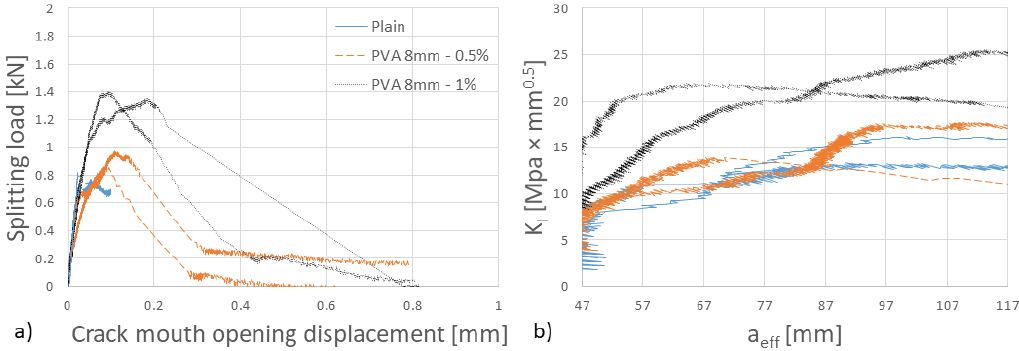
Figure 8. ( a ) Splitting load (SL) versus crack mouth opening displacement (CMOD) curves of concrete-FRC interfaces and ( b ) crack growth resistance curves in terms of stress intensity factor, K I , versus effective crack length, a eff.